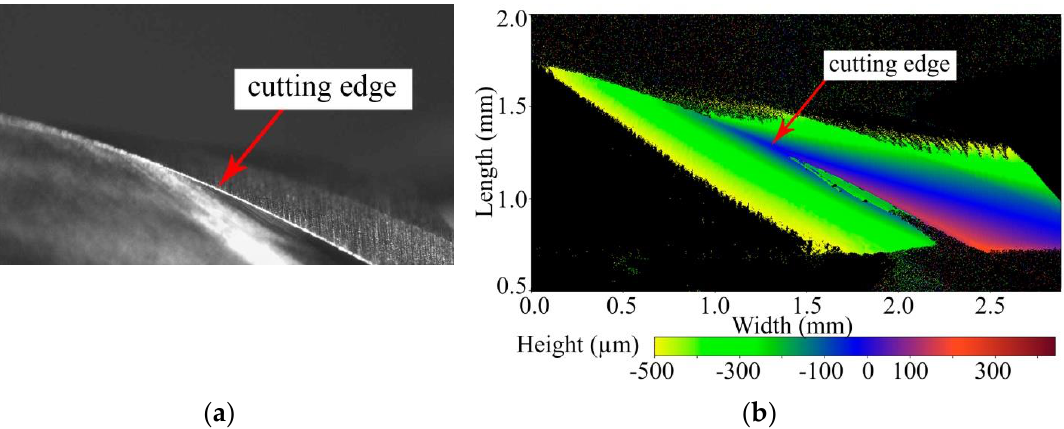
Figure 4. The end mill tooth at a distance of 7 mm from the mill end. ( a ) Image from optical 3D scanning camera; ( b ) topography of the cutting edge.